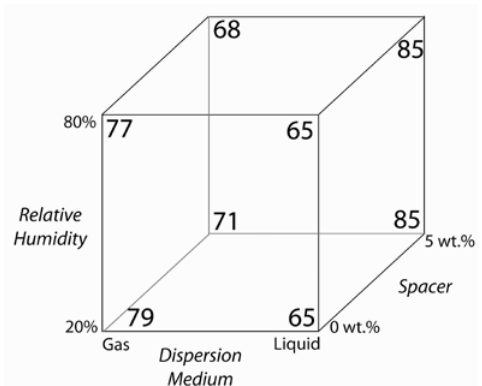
Experimental design dispersion results. The figure shows the results for airborne concentration for all of the experiments used to investigate the effect of humidity, spacer, and disper- sion medium. The conditions for optimum dispersion can be seen to result from 5 wt% spacer and liquid CO 2